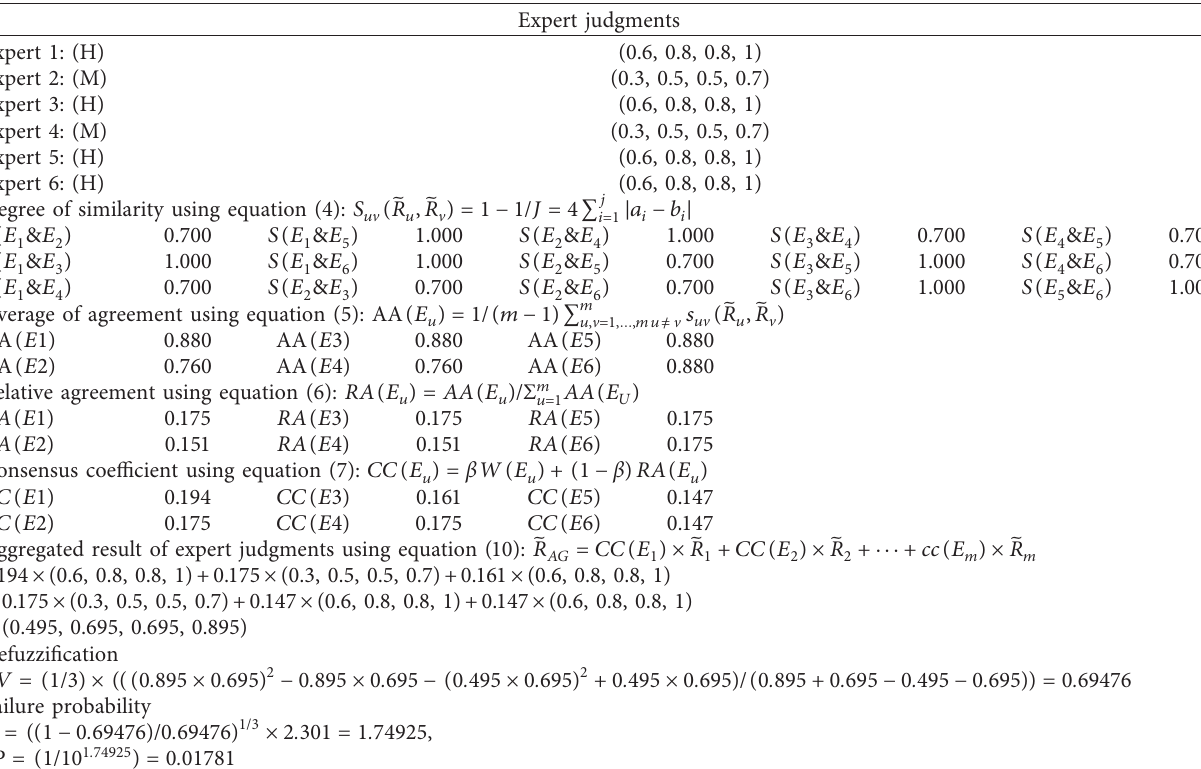
Table 7: The probability calculation process for “poor communication and cooperation among projects ( R 15).” Expert judgments